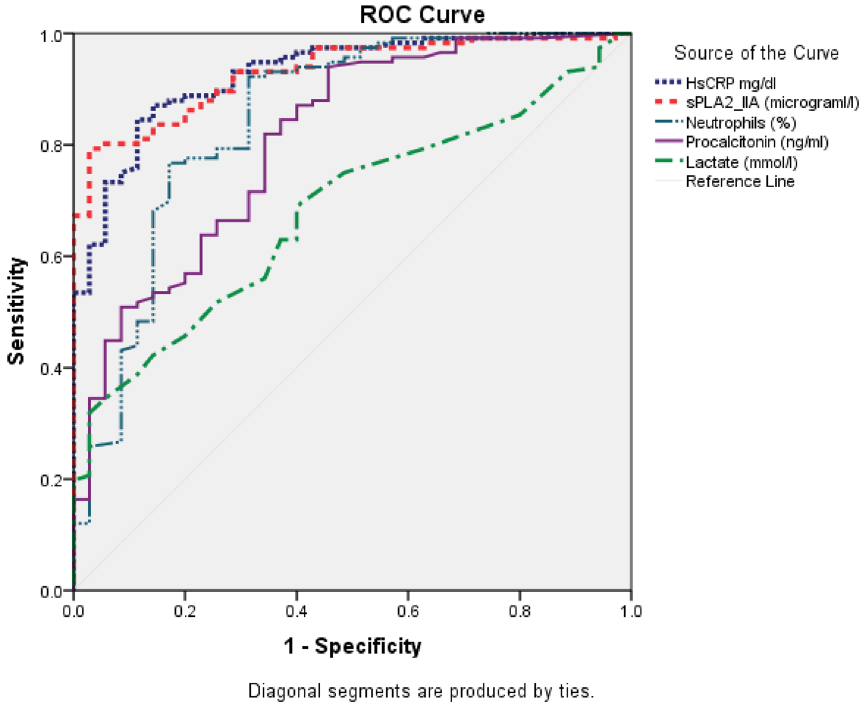
Figure 3. AUROCs of five tested biomarkers in differentiating bacterial infection in ED. This figure showed that all biomarkers able to predict sepsis and bacterial infection (BI). High-sensitive CRP, sPLA2-IIA, and N% have the highest AUROC among all for both sepsis and BI detection in ED. AUROC = Area Under Receiver Operating Characteristic Curve; hsCRP = High-Sensitive C-Reactive Protein; sPLA2-IIA = Secretory